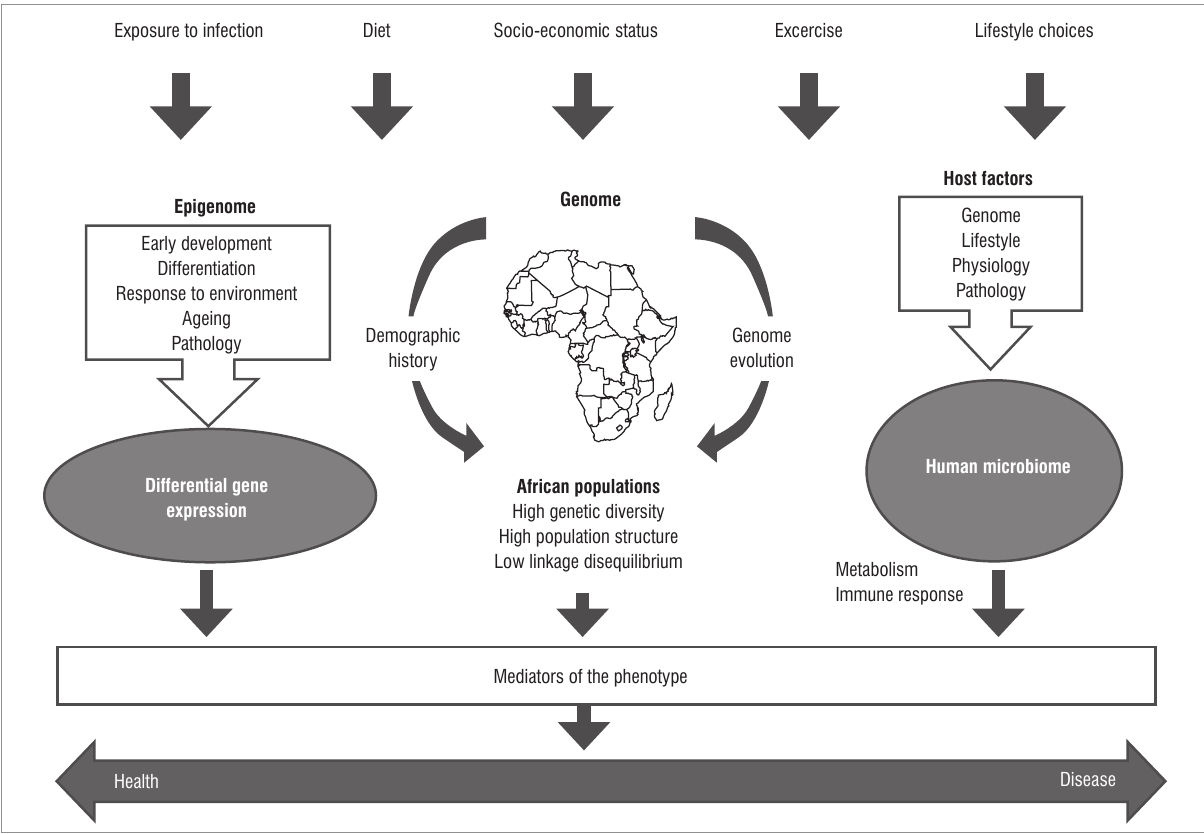
Source: Ramsay 31 . Reprinted with permission of the Federation of the European Biochemical Societies. Figure 3: A complex set of interdependent and parallel processes that govern health and susceptibility to disease. They include the role and function of genetic variation (central panel), epigenetic remodelling (left panel) and the microbiome (right panel), with the latter two significantly affected by the environment and acting as mediators of the